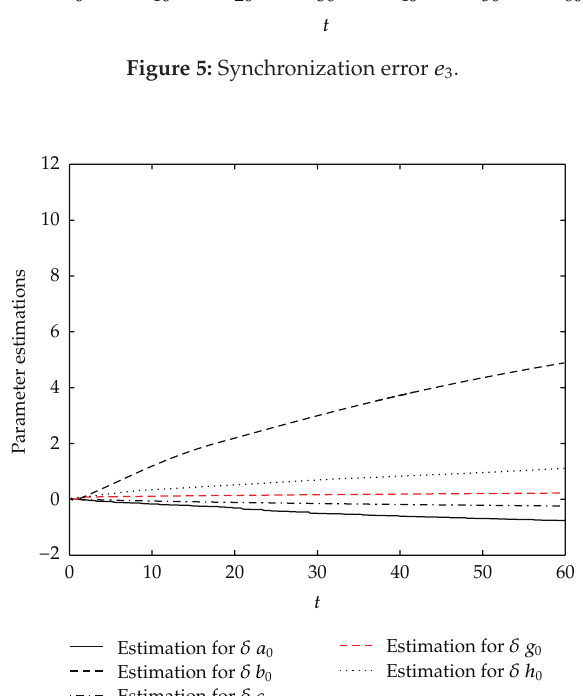
Figure 6: Curves of parameter estimations for the master